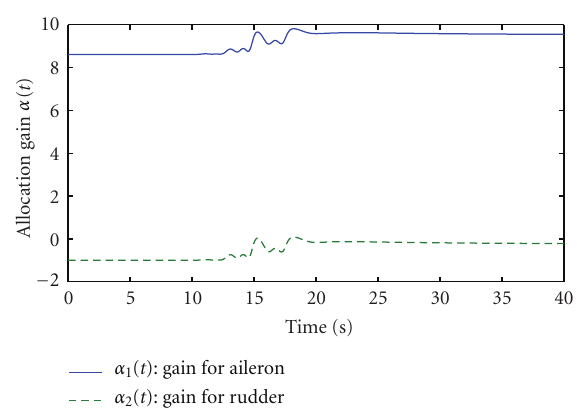
Figure 8: Time history of allocation gains (Case 2).